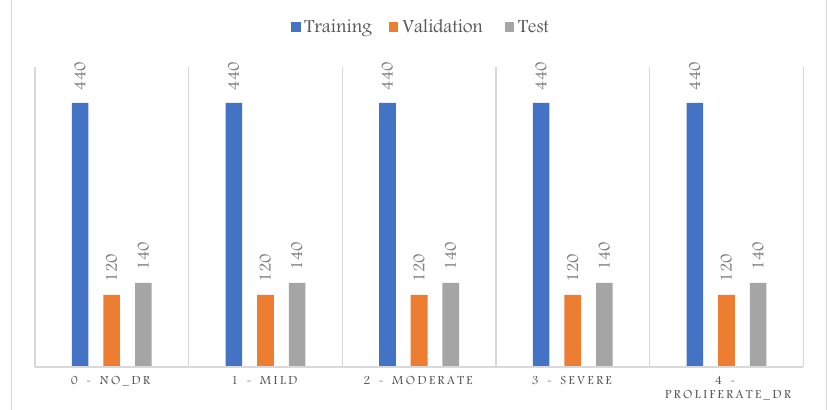
Figure 3. DR dataset distribution after balancing the five categories.